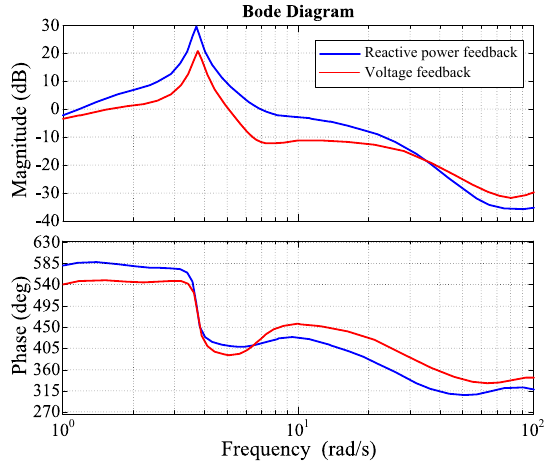
Figure 5. The bode diagram of reactive power feedback control and voltage feedback control.